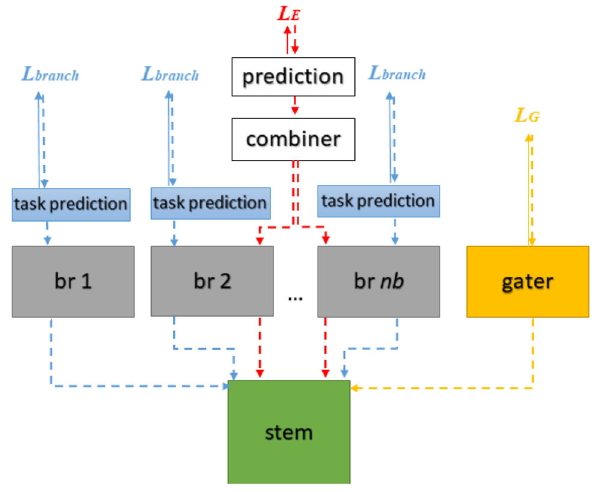
Fig. 2 Backpropagation flow (best viewed in color). The three losses are guiding the entire training step: for the final prediction (with red) L E , for the gater L G (with orange), and for the individual branches L branch (blue). The dotted lines represent the backpropagation pass cor- responding to each loss. In this example, the gater selects the branches 2 and nb , so the independent layers of branch 1 are not altered by L E at this specific step. The independent gater layers are also not dependent on the final classification